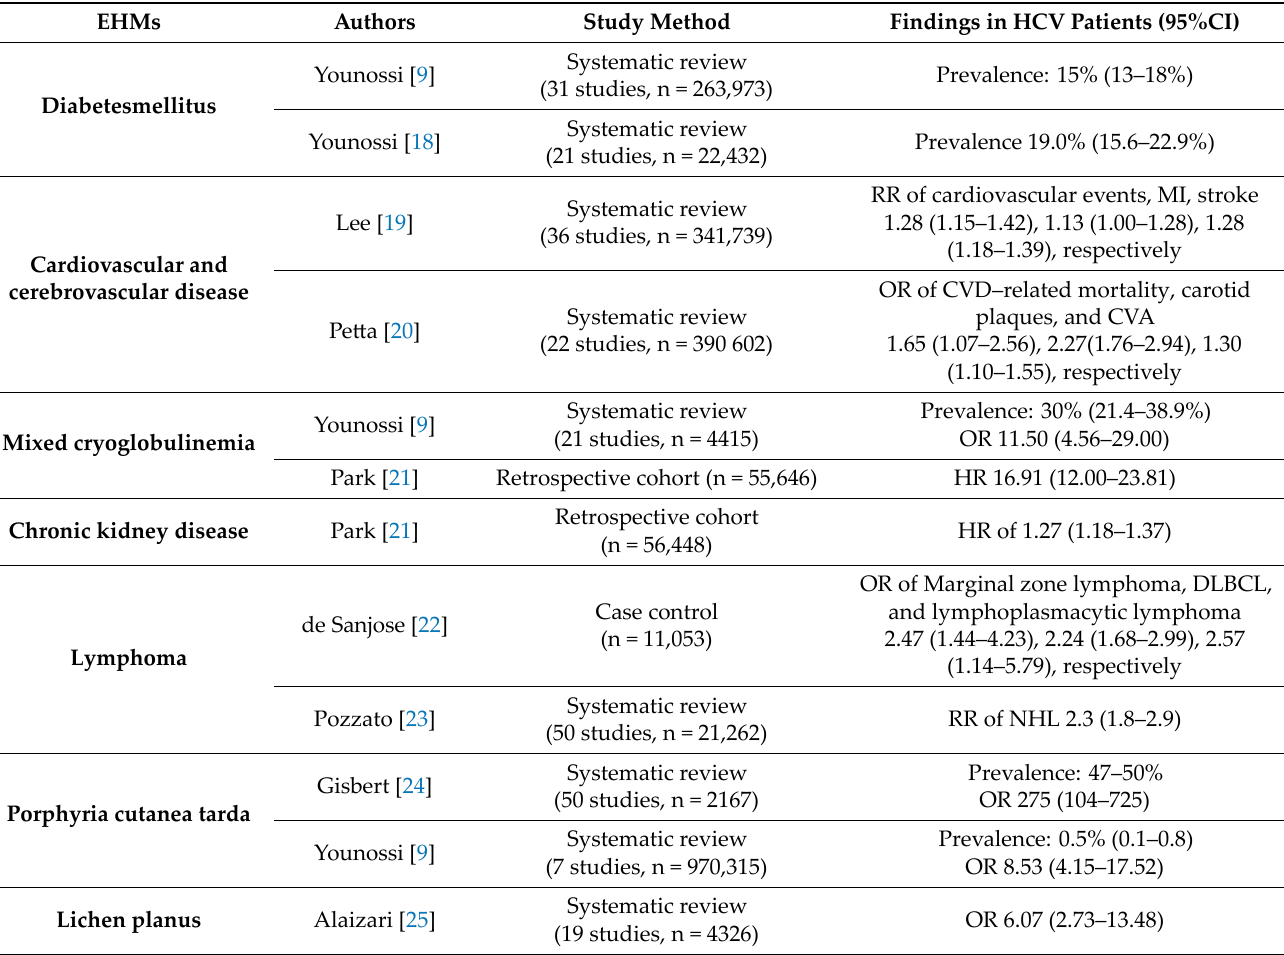
Table 1. Prevalence of extrahepatic manifestations in HCV